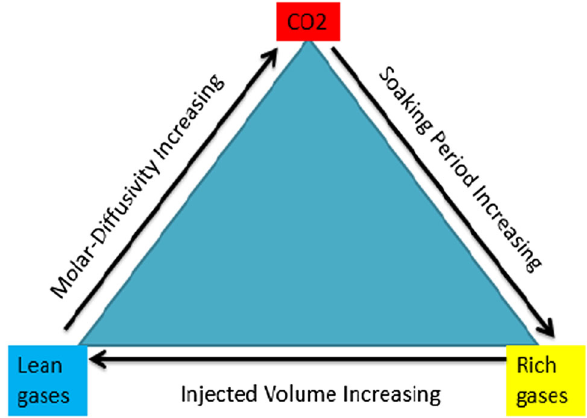
Fig. 18 Applicability of miscible gases EOR in Bakken